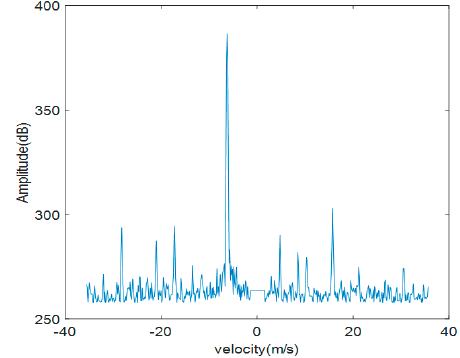
Figure 14. Regularized log-Doppler spectrum.